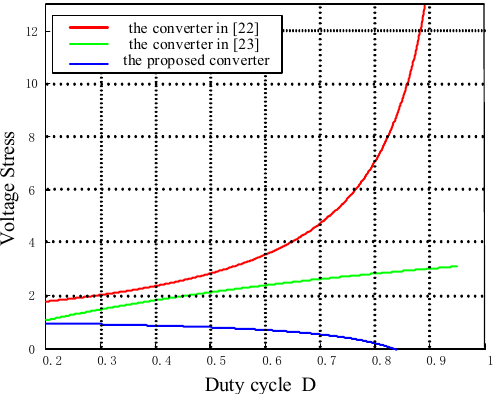
Figure 10. Comparison of voltage gain of converters.